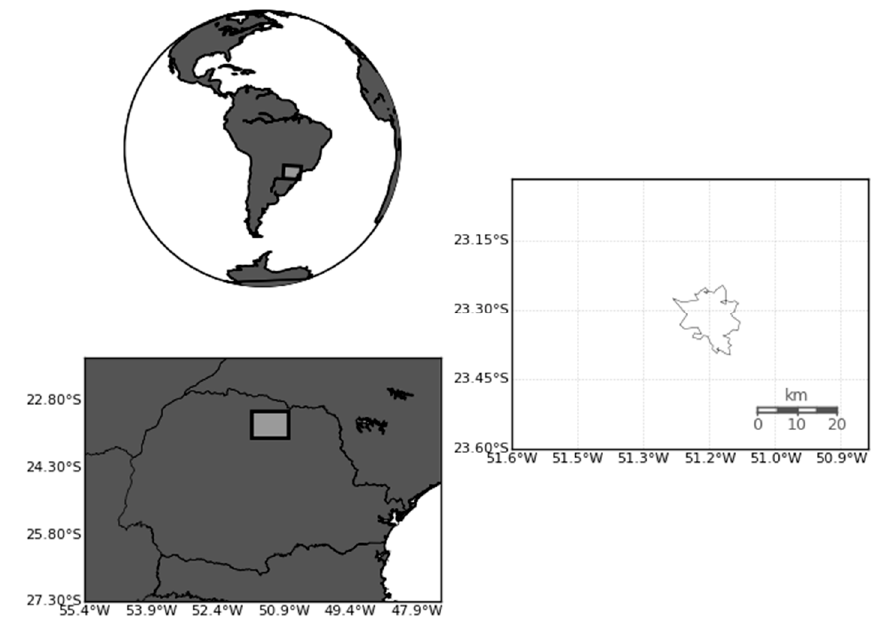
Figure 2. Localization of the city of Londrina. On the right map, the grid with more resolution. The shape map on this figure is the urban area of